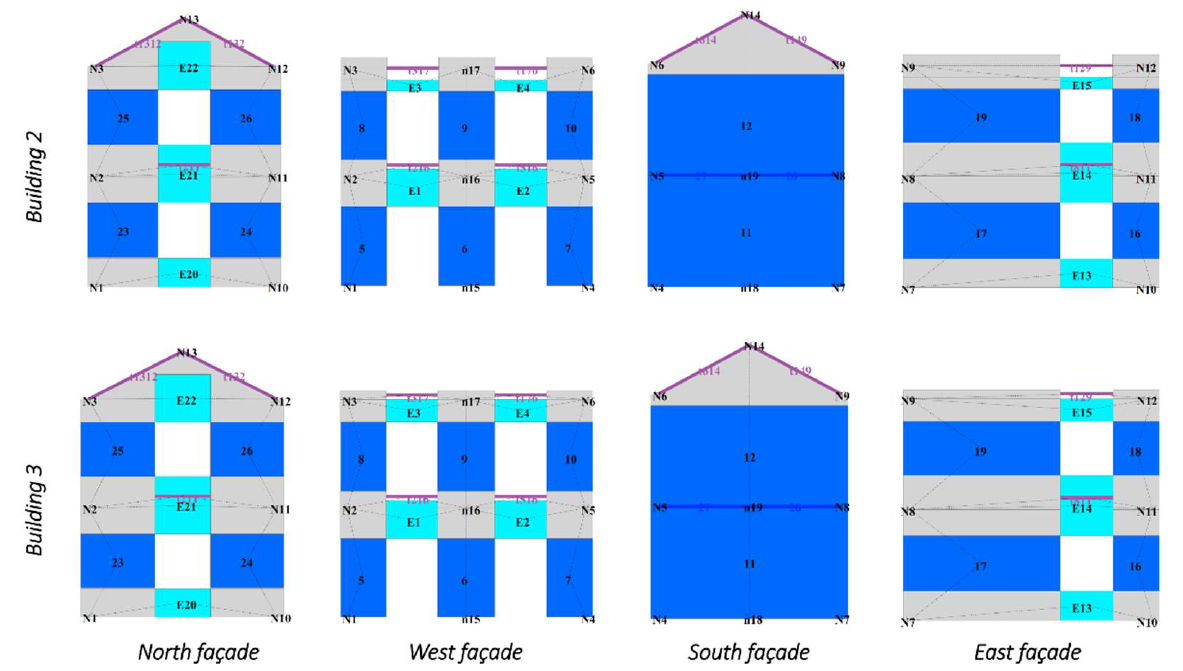
Figure 11. Geometrical discretization of walls in Building 2 and Building 3 models.